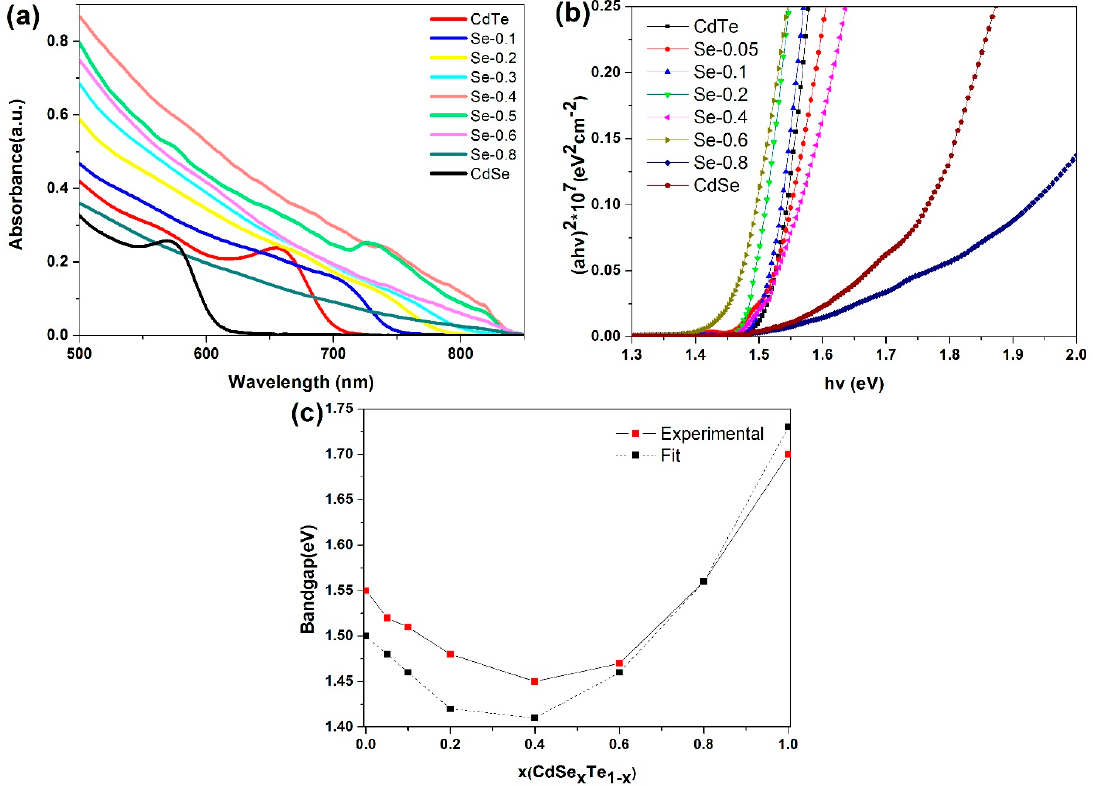
Figure 3. ( a ) The absorption patterns of the CdSe x Te 1 − x NCs with different Se content; ( b ) the plots of (ahv) 2 versus photon energy of the CdSe x Te 1 − x NCs thin film with different Se content; and ( c ) the bandgap value of the CdSe x Te 1 − x NCs thin film with different Se content.